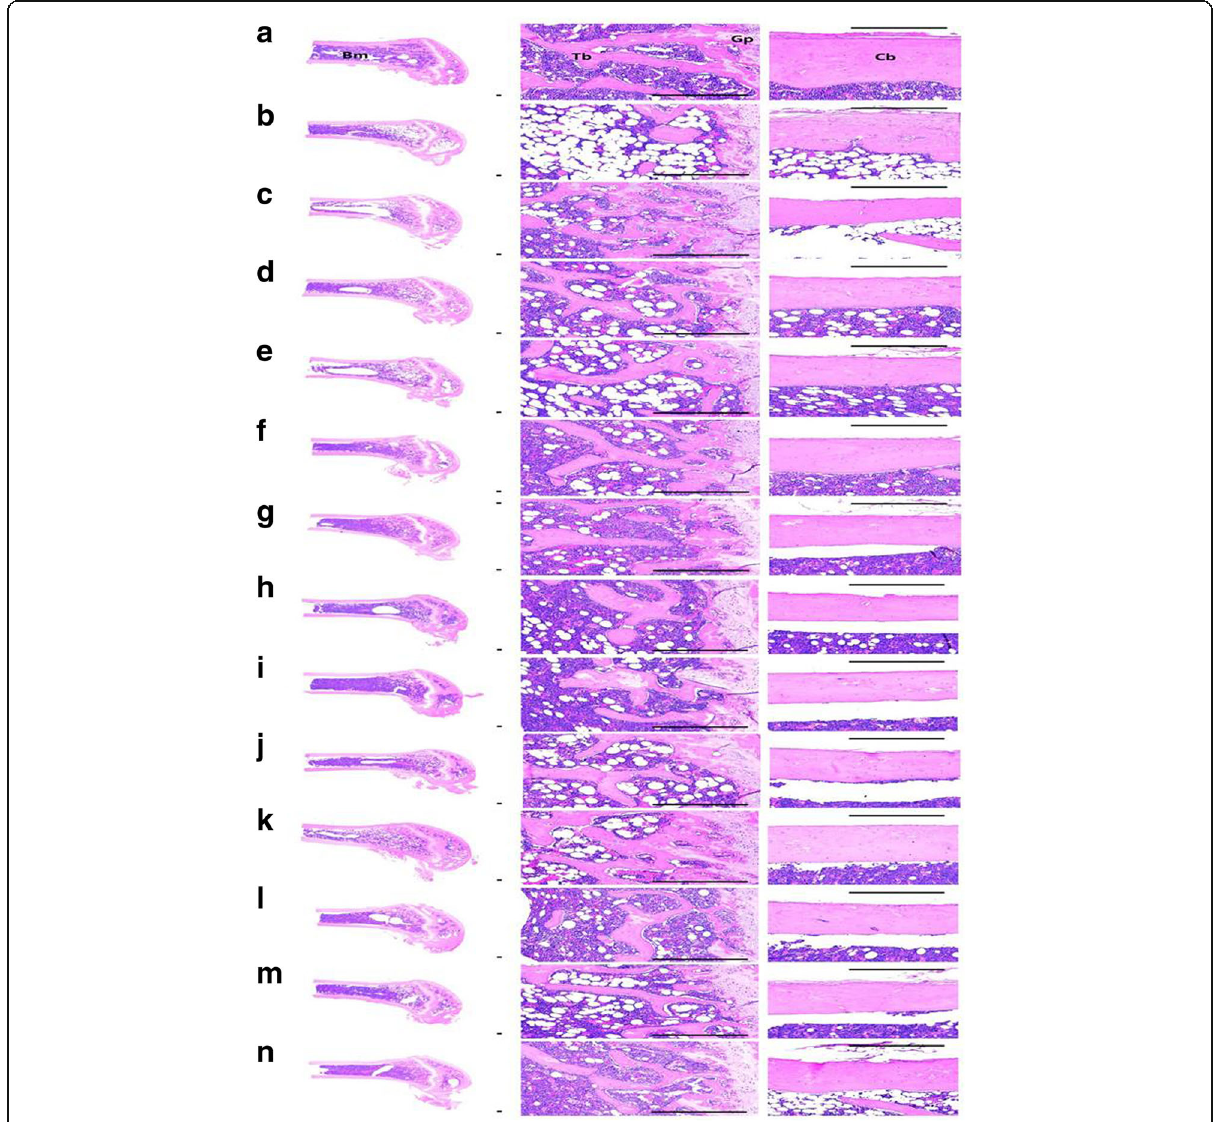
Fig. 5 Representative histological profiles of the left femur, taken from sham-operated and OVX mice. a =Sham-operated and distilled water administered sham vehicle control mice. b =Distilled water administered OVX control mice. c =RES 2.5 mg/kg orally administered OVX mice. d =EAP single formula 200 mg/kg orally administered OVX mice. e =TM single formula 200 mg/kg orally administered OVX mice. f =EAP:TM 1:1 (g/g) mixed formula 200 mg/kg orally administered OVX mice. g =EAP:TM 1:3 (g/g) mixed formula 200 mg/kg orally administered OVX mice. h = EAP:TM 1:5 (g/g) mixed formula 200 mg/kg orally administered OVX mice. i = EAP:TM 1:7 (g/g) mixed formula 200 mg/kg orally administered OVX mice. j = EAP:TM 1:9 (g/g) mixed formula 200 mg/kg orally administered OVX mice. k = EAP:TM 3:1 (g/g) mixed formula 200 mg/kg orally administered OVX mice. l = EAP:TM 5:1 (g/g) mixed formula 200 mg/kg orally administered OVX mice. m = EAP:TM 7:1 (g/g) mixed formula 200 mg/kg